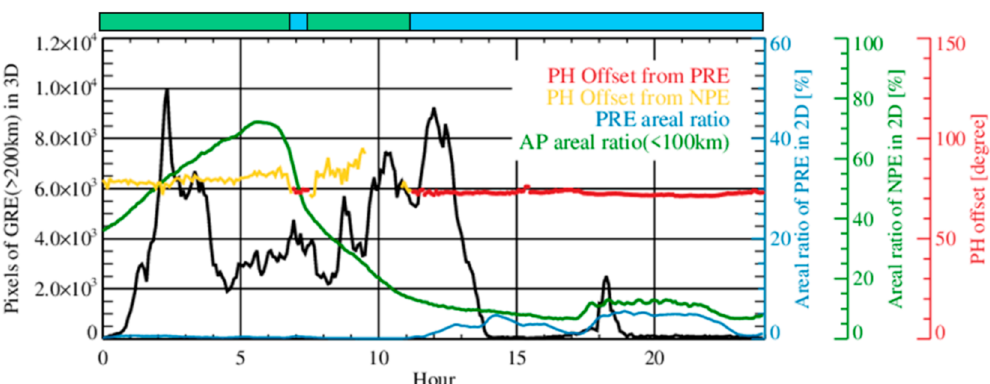
Figure 4. Time series of the o ff set value of di ff erential phase calculated from the precipitation echo (red line, blue shaded period) and non-precipitation echo (yellow line, green-shaded period), as observed by the BRI at the lowest elevation angle on 12 March 2020. Blue and green lines indicate the areal ratio of precipitation echo (PRE) and non-precipitation echoes (NPE), respectively.